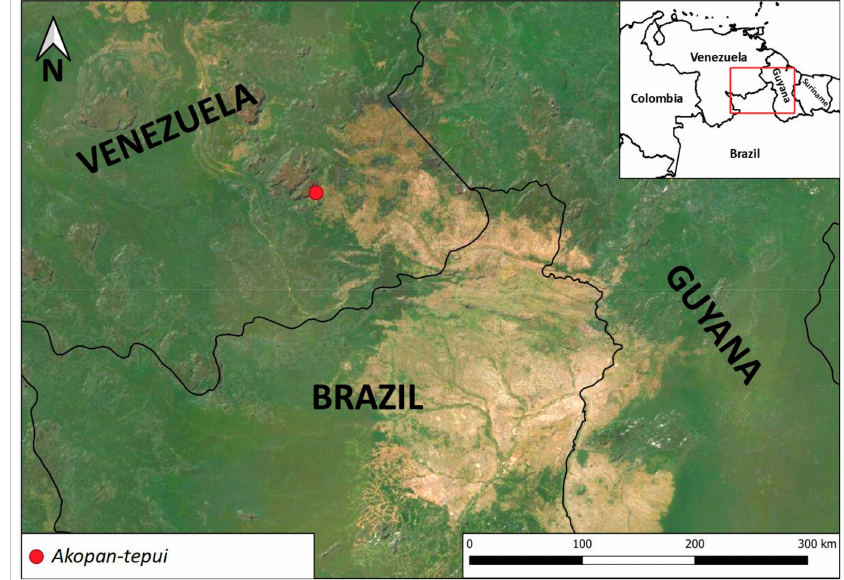
Figure1. MapshowingthelocationofAkopan-tepuiinVenezuela(mapbyM.Wrazidlo,made with